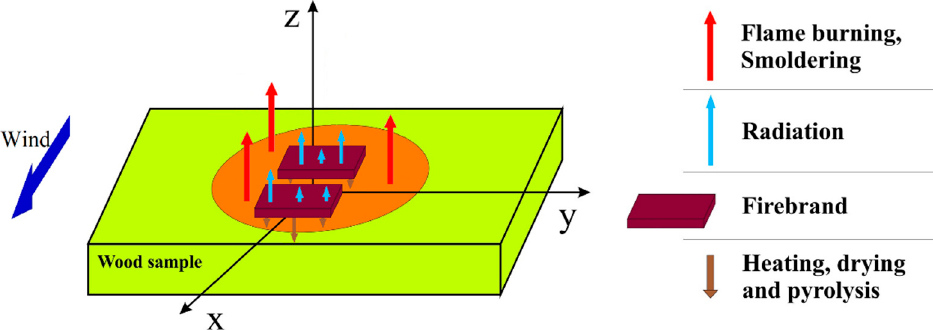
Figure 1. Process diagram.